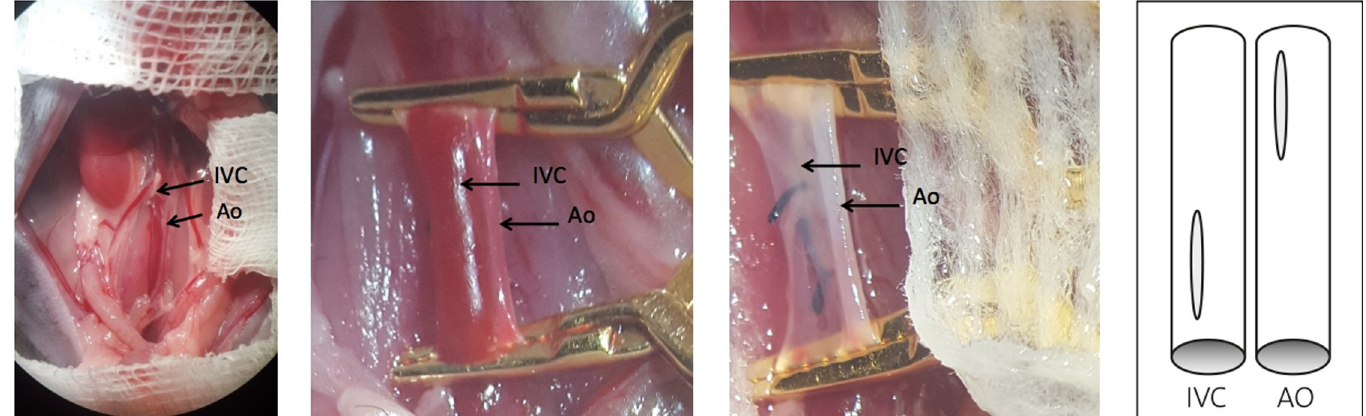
Fig 3. Photographic illustration of the recipient situs. Fig 3A shows the infrarenal abdominal aorta (Ao) and the inferior vena cava (IVC). In the left upper corner, the right kidney can be identified. At the lower border the reproductive organs can be found, dorsally of the reproductive organs is the iliac bifurcation. Fig 3B shows the Ao and the IVC after clamping. Fig 3C shows the Ao and the IVC after aortotomy and venotomy, and flushing of the vessels. Fig 3D shows a schematic illustration of the aortotomy (infra-renal abdominal aorta) and venotomy (subrenal IVC) after clamping the vessels.